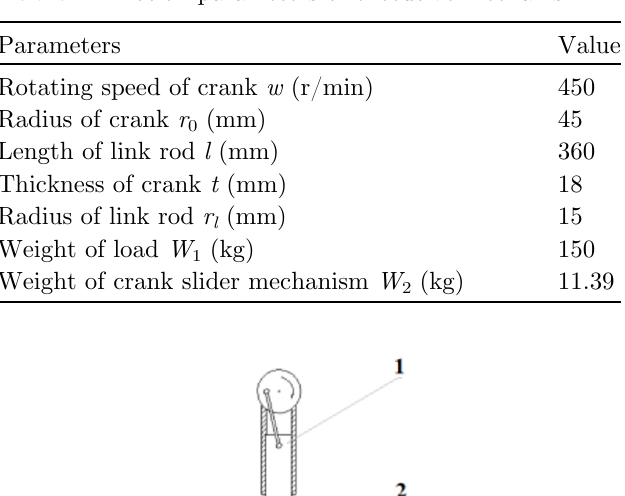
Table 1. Motion parameters of executive